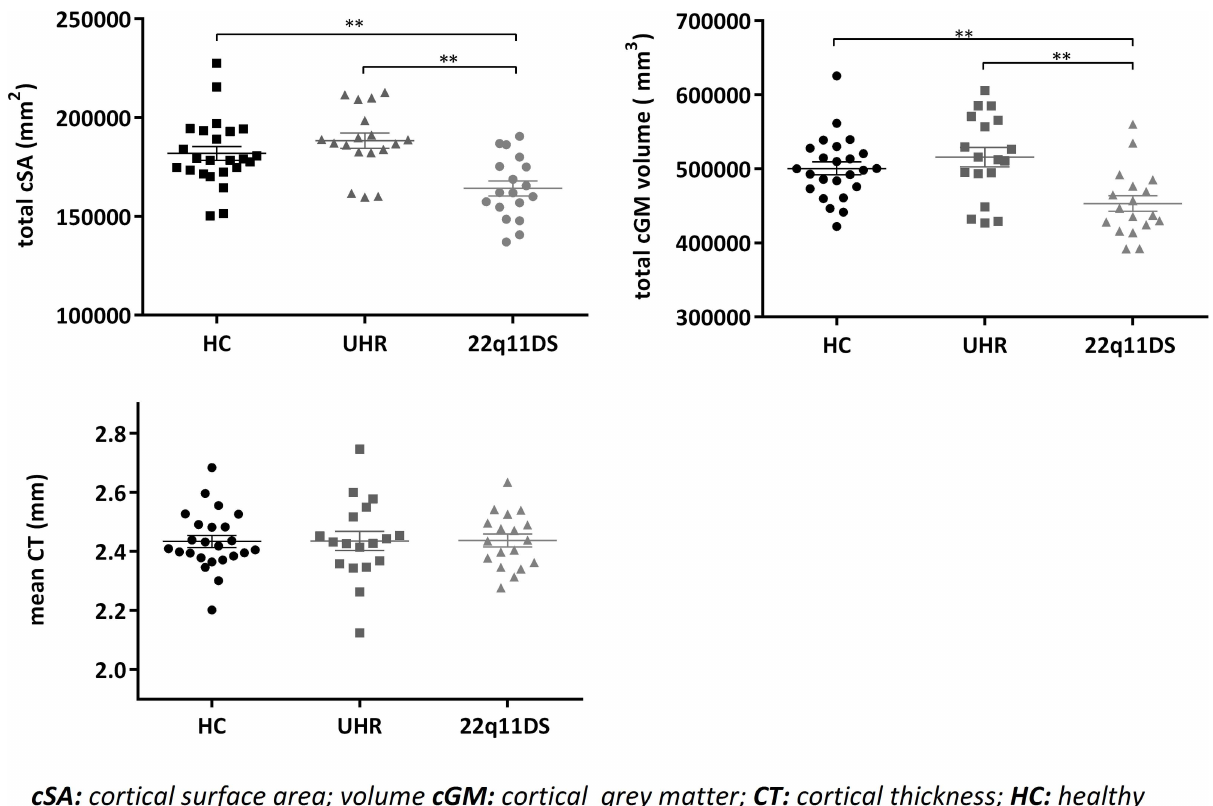
Fig 1. Total cSA, total cGMV and mean CT per group. Plots show that 22q11DS subjects had significantly lower total cSA and cGMV comparedto UHR and HC. No between-group differences were found in mean CT. UHR subjects had comparablemeasures of cGMV, total cSA and averageCT compared to HC. See S1, S2, S3 and S4